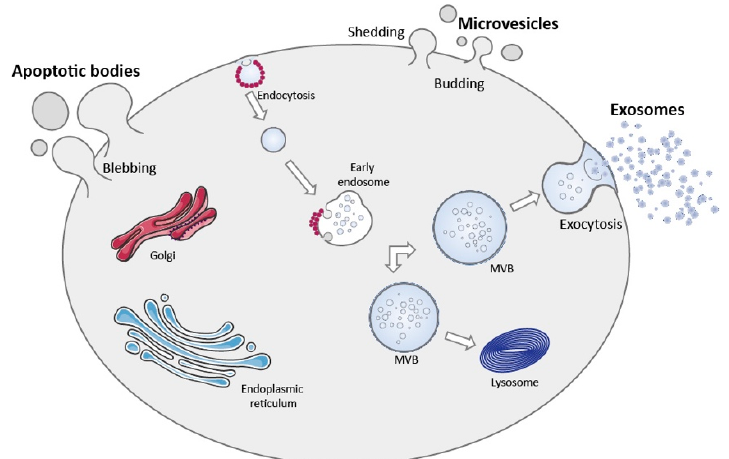
Figure 1. Schematic representation of the mechanisms involved in EV biogenesis and release. Microvesicles are shed into the extracellular space by direct budding of the plasma membrane. Apoptotic bodies are released by membrane blebbing of apoptotic cells upon cell disintegration. Exosomes are small EVs derived from the endocytic pathway that are released into the extracellular milieu by the fusion of the MVBs with the plasma membrane. During their formation MVBs can either release their content into the extracellular space through exocytosis or alternatively fuse with lysosomes leading to vesicle degradation.